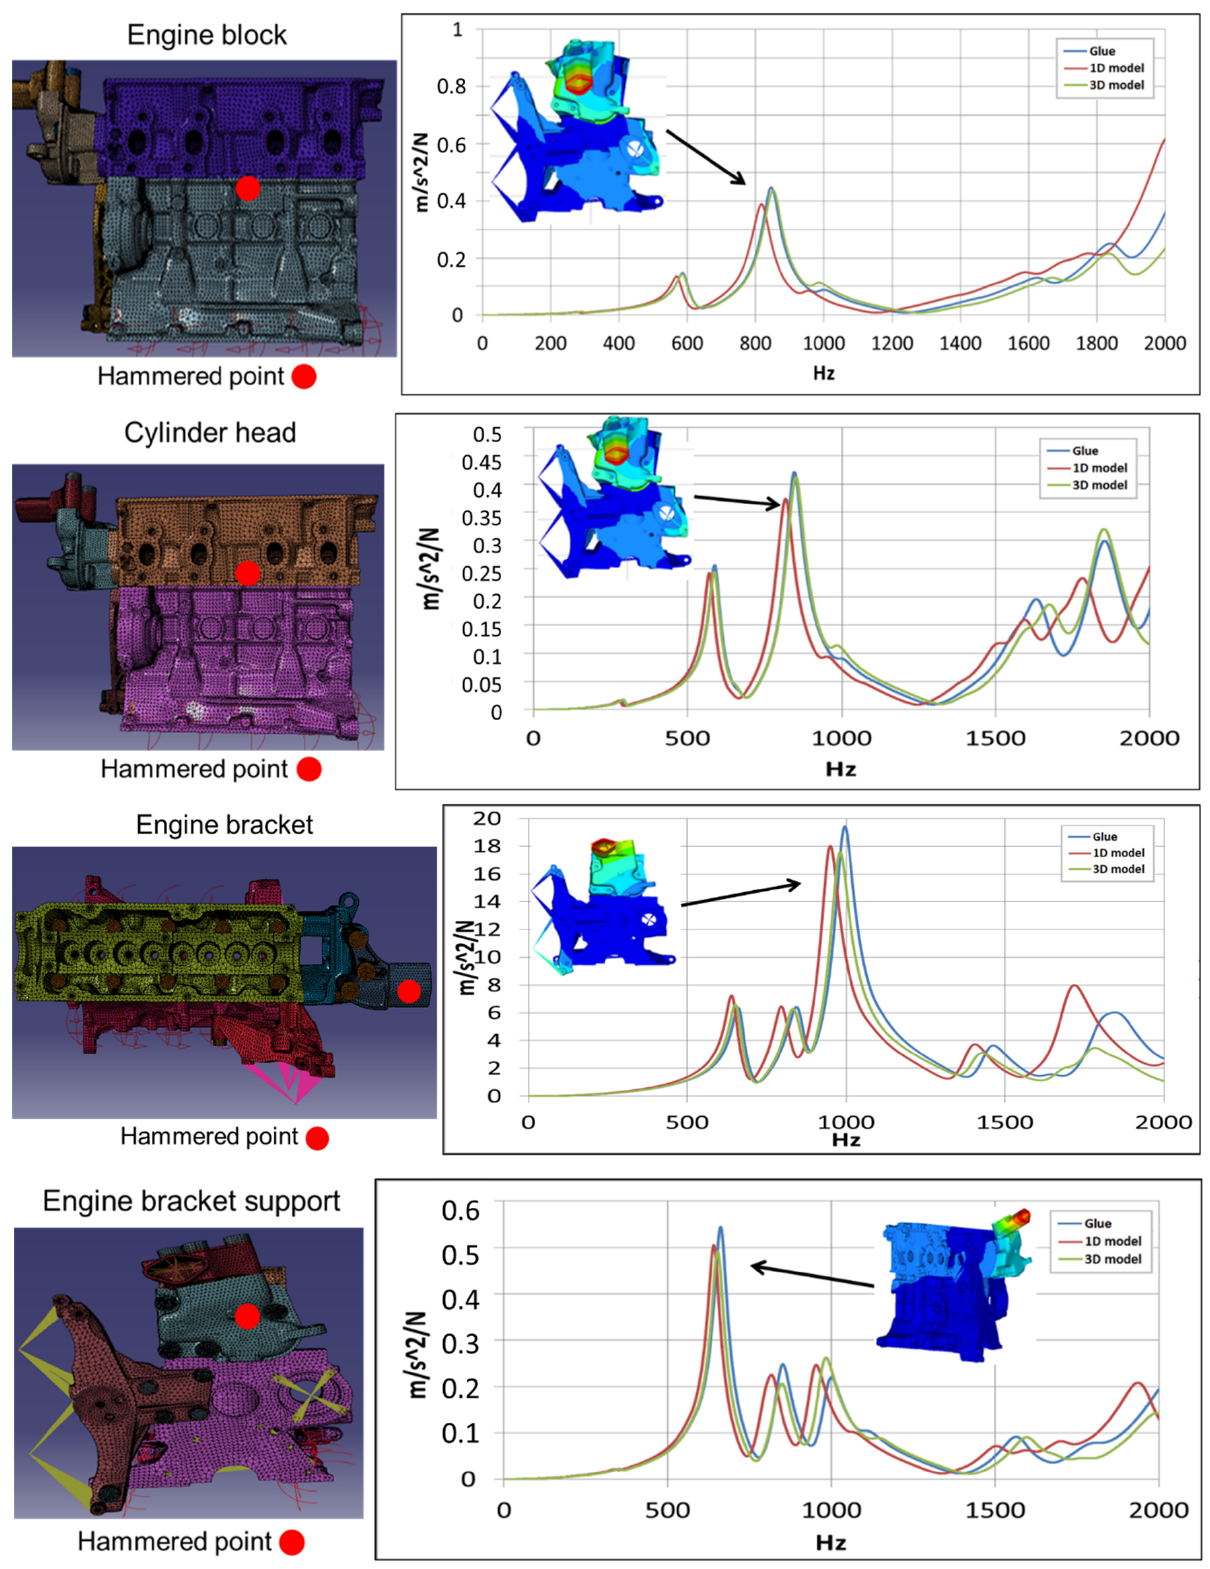
Figure 7. FRFs in the frequency range 0–2000 Hz, for the four hammered positions with highlight of eigenmodes related to the highest resonance amplitudes.